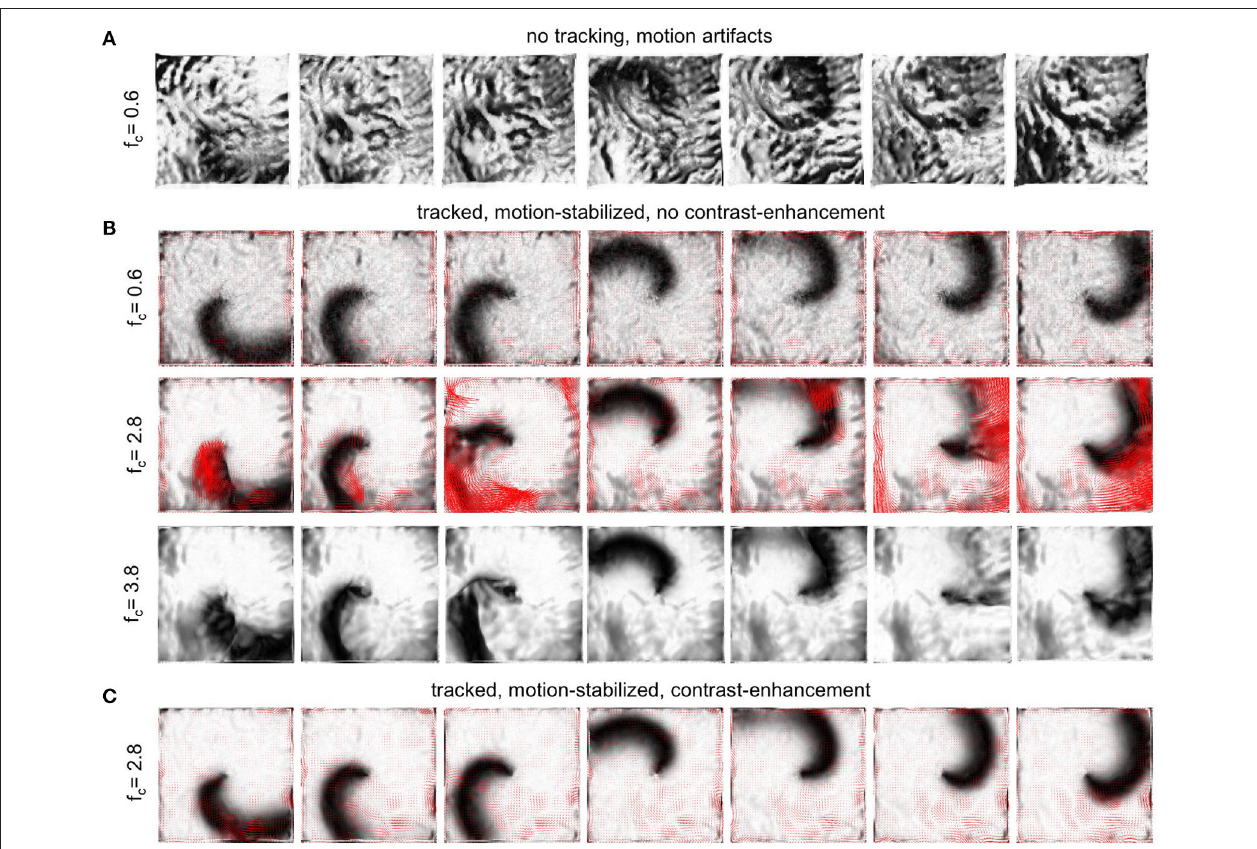
FIGURE 11 | Efficacy of motion compensation and tracking error determined with synthetic optical maps showing contracting, fluorescing cardiac tissue. See also Supplementary Videos 3 and 4 . (A) Deformed, non-tracked optical maps obscured by motion artifacts for weak to moderate signal strength ( f c = 0.6). (B) Motion-stabilized optical maps with substantial artifact reduction for various signal-to-contrast ratios f c = 0.6, f c = 2.8, f c = 3.8 (increasing signal strength) after tracking and warping. Red vectors (row 1 & 2) indicate tracking errors, calculated as mismatches between the tracked and actual simulated tissue configuration. While tracking is sufficiently accurate for small fluorescent signal strengths ( f < c , here f c < 0.6), the tracking error increases with increasing signal strengths, with mismatches emerging particularly close to the wave front. For very strong signals ( f > c , here f c = 3.8) the warped, motion-stabilized images become visibly distorted as a result of the erroneous tracking. (C) Substantial reduction of tracking errors by introducing contrast-enhancement, amplifying local image gradients to minimize accidental tracking of the electrical wave and the related intensity modulations it causes in the video images. Contrast-enhancement improves the accuracy of the tracking and maintains robust and sufficiently accurate tracking with larger signal strengths ( f c > 2.8), see also Figure 12 . All optical maps are pixel-wise normalized over